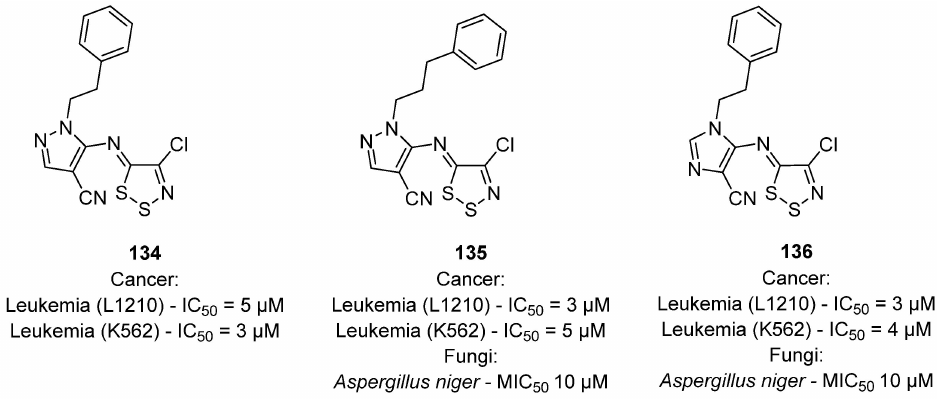
Figure 29. Initial 1,2,3-dithiazoles reported with anticancer activity in 2002 by Baraldi et al. [16].